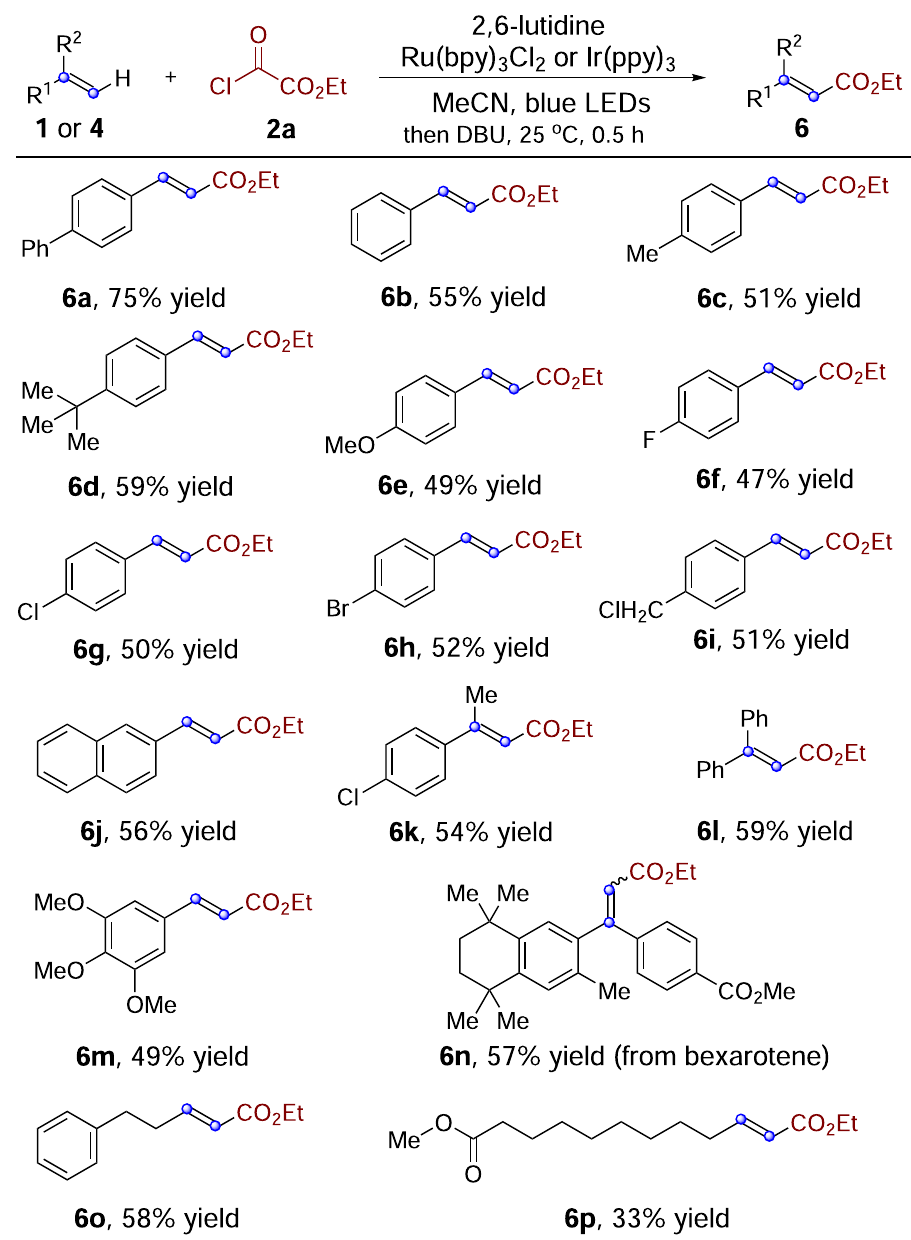
Fig. 4 Synthesis of α , β -unsaturated esters. Isolated yields based on alkene 1 or 4